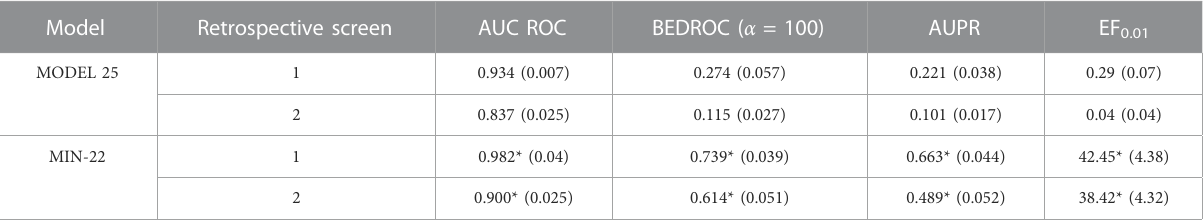
TABLE 3 Performance of the best individual model and the best model ensemble in retrospective screening experiments. The standard deviation of the enrichment metrics (obtained through bootstrapping) is presented in parentheses.